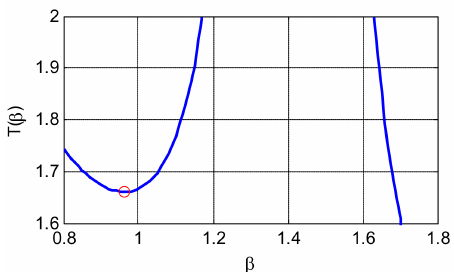
Figure 4. Local enlargement of normalized expectation